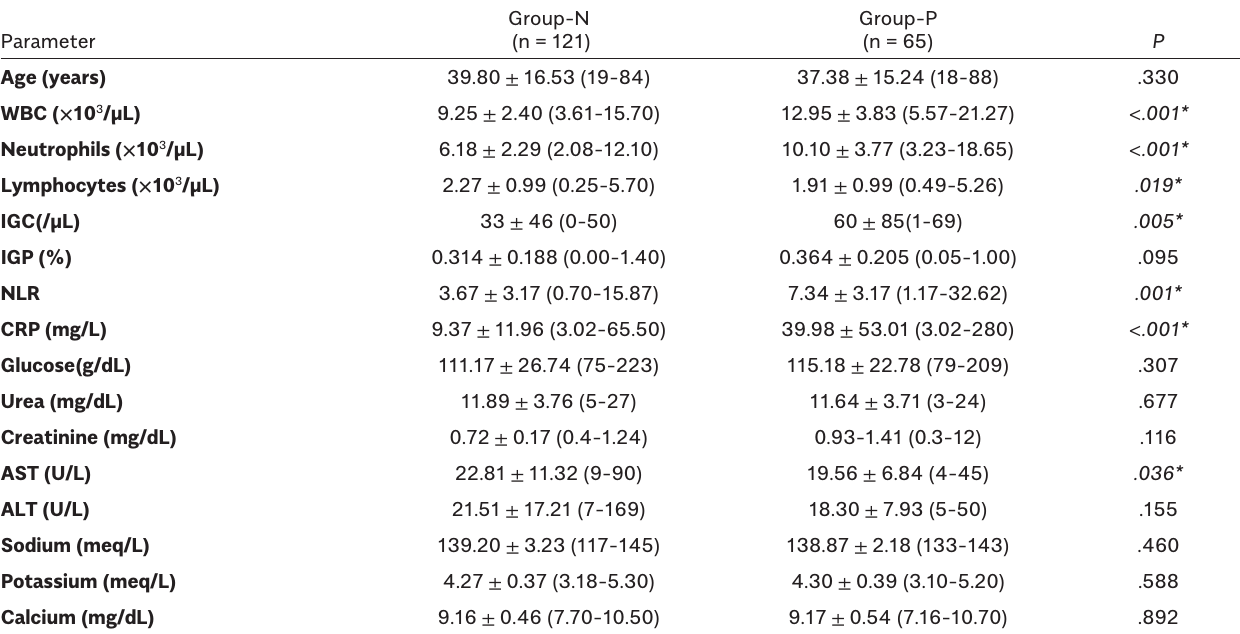
Table 2. The Hematological and Biochemical Parameters of the Groups and Their Comparison Results